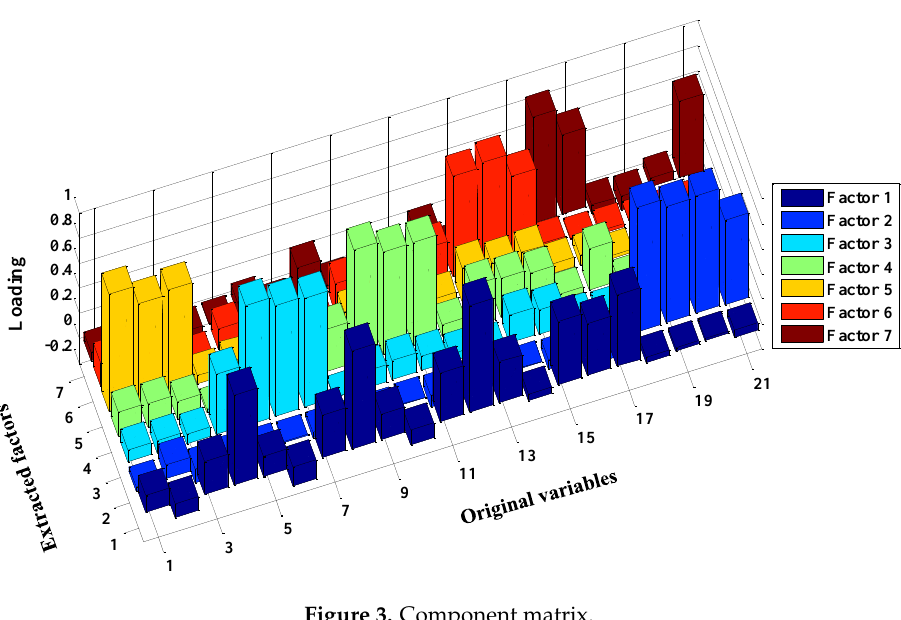
Figure 3. Component matrix. Table 3. Number related variables and factor